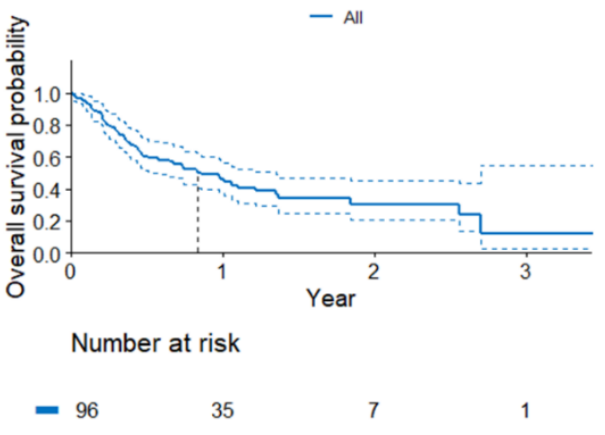
Figure 4. Probability of survival in the entire analyzed group.